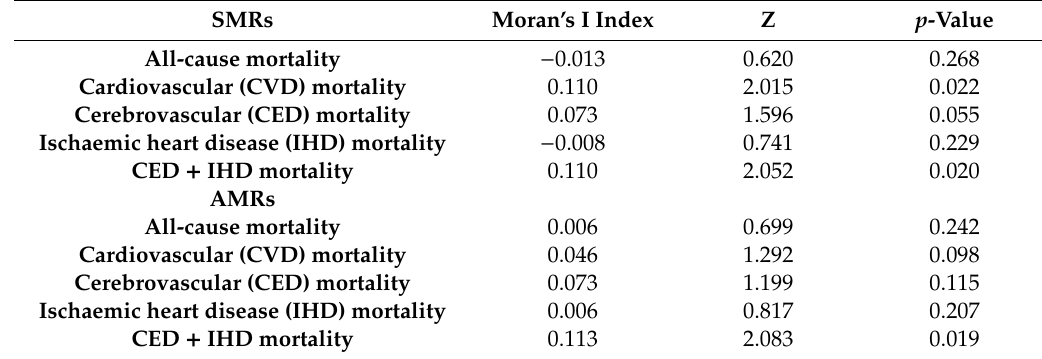
Table 5. Spatial autocorrelation following Moran’s I index of the smoothed standardized mortality ratios (SMRs) and age-adjusted mortality rates (AMRs) of the eight municipalities (Castell ó n, 1991–2011 period). SMRs Moran’s I Index Z p